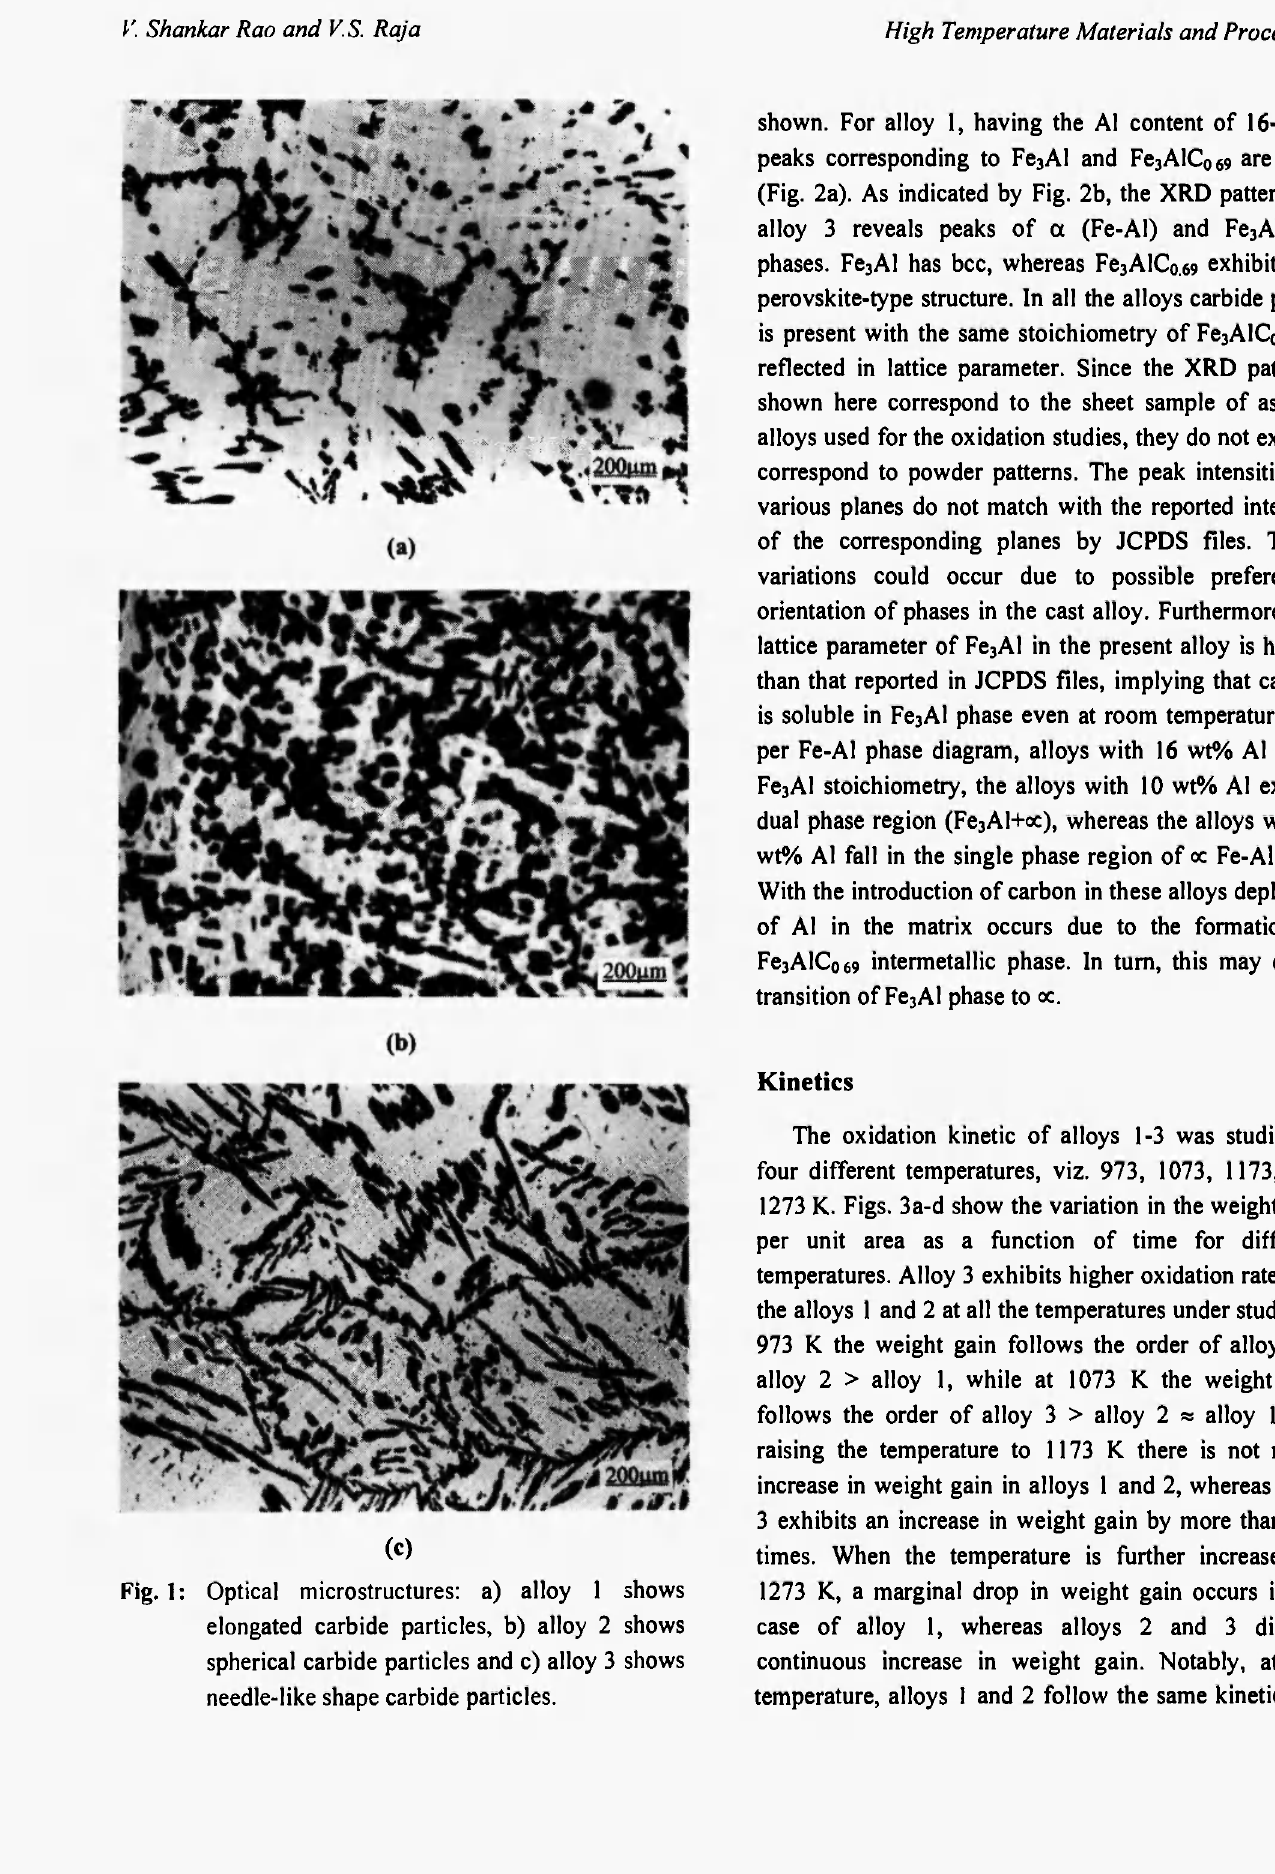
Fig. 1: Optical microstructures: a) alloy 1 shows elongated carbide particles, b) alloy 2 shows spherical carbide particles and c) alloy 3 shows needle-like shape carbide